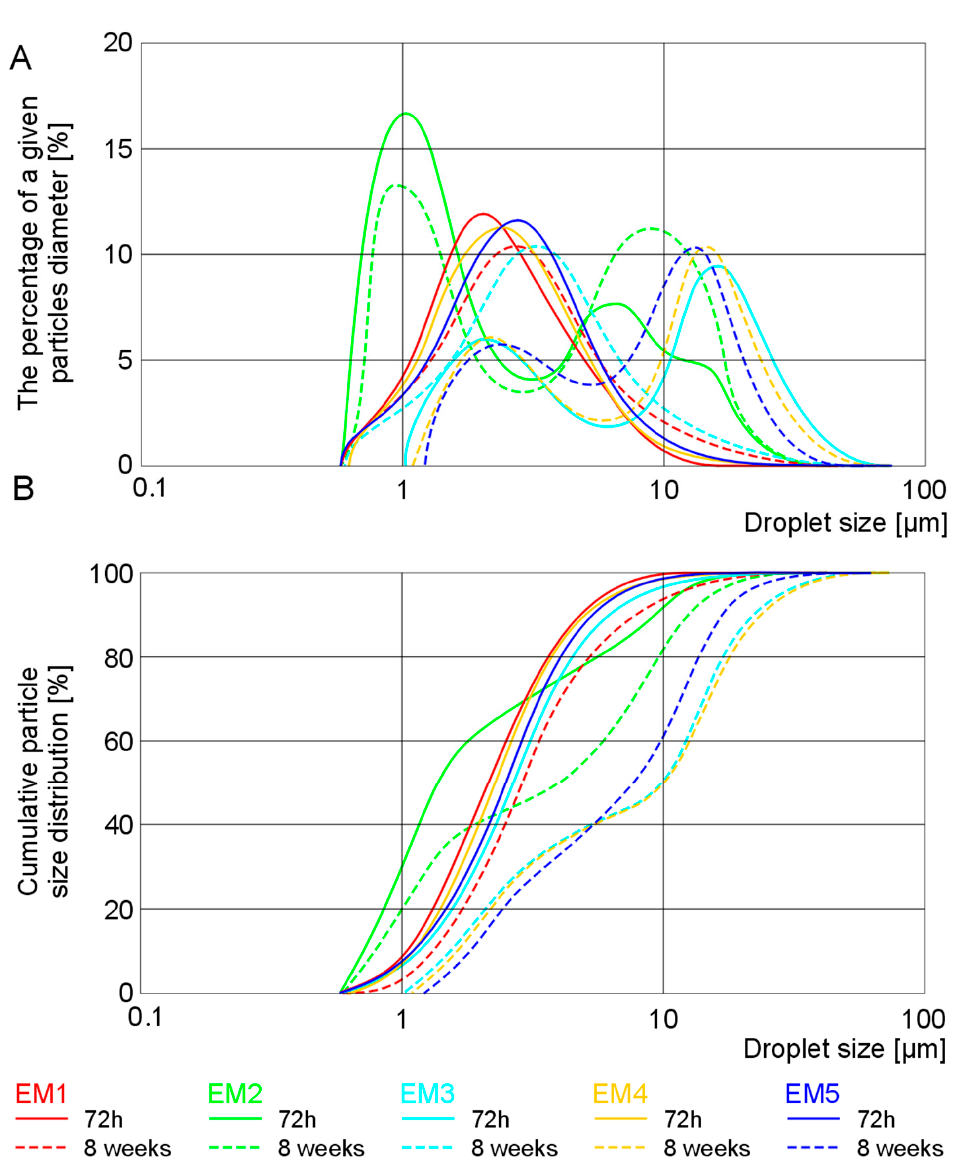
Figure 1. Particle size distributions of the prepared emulsions determined after 72 h and 8 weeks from preparation. ( A ) Differential curve; ( B ) cumulative curve.